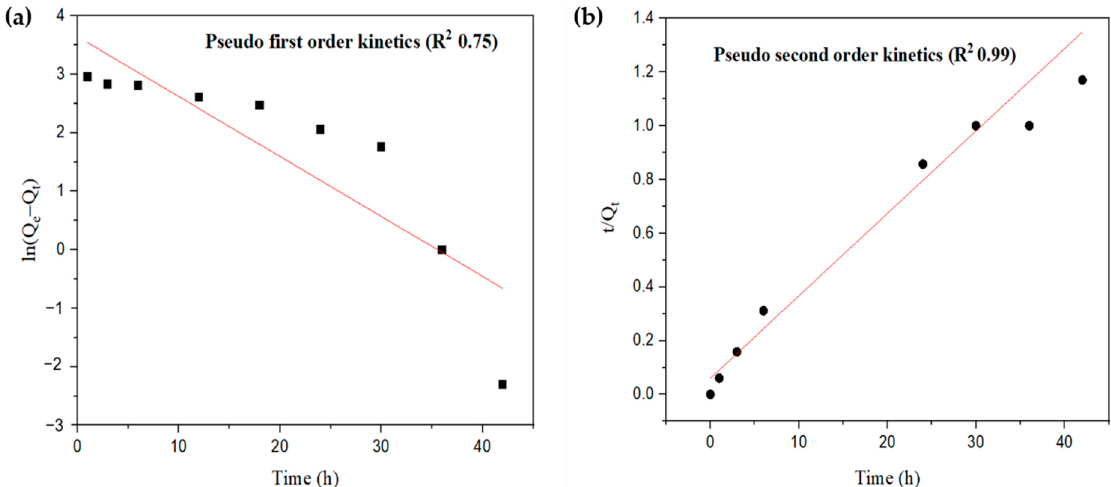
Figure 9. Kinetic models for Ni 2+ adsorption by PSDB; ( a ) pseudo − first order; ( b ) pseudo − second order. Table 3. Adsorption kinetics and isotherm parameter values for adsorption of Ni 2+ by PSDB.